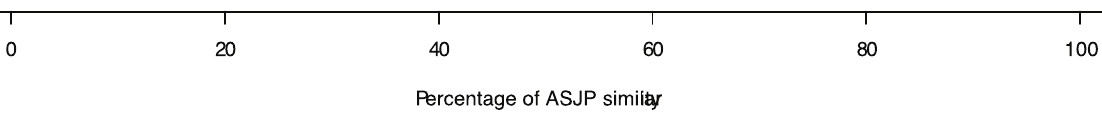
Figure 4. Combining ASJP with 2 - grams and 3-grams: The ASJP dates are combined with 2 - gram dates and 3-gram dates in different proportions ranging from 1% to 100% at an interval of 1.